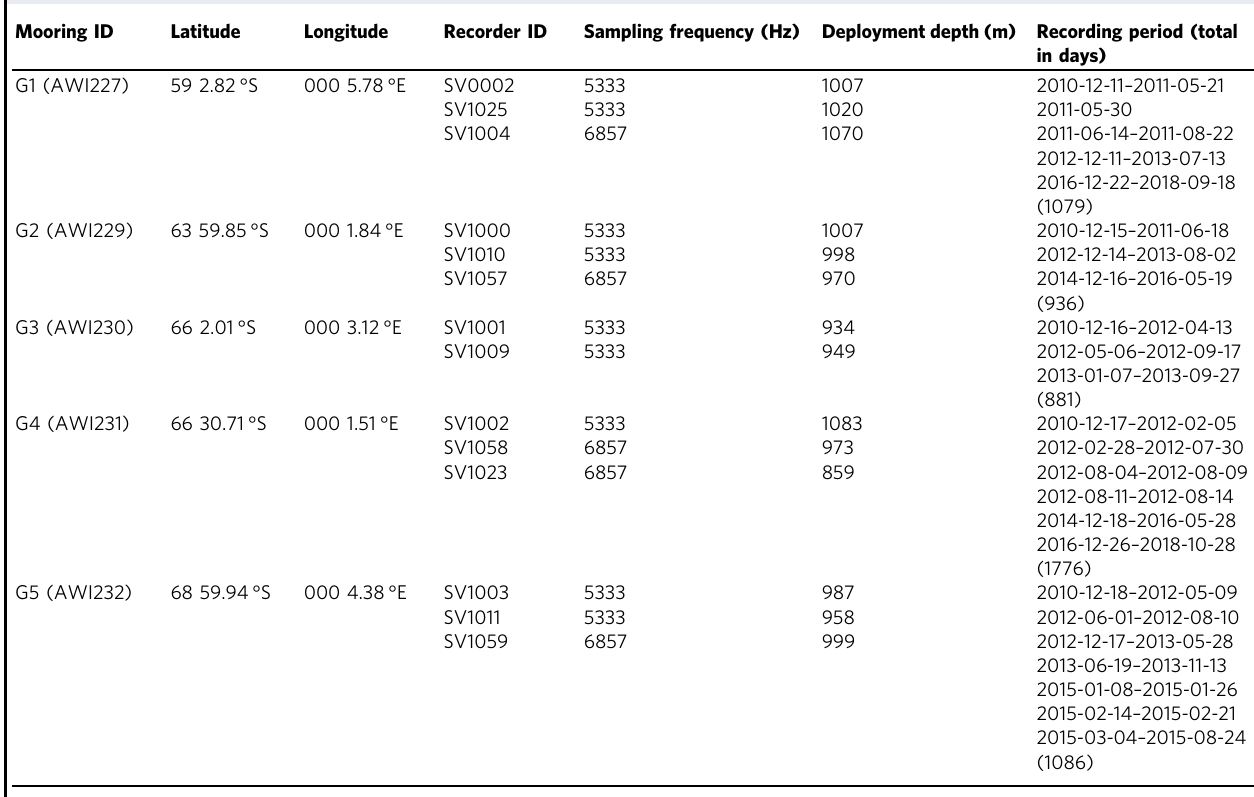
Table 2 Overview of passive acoustic